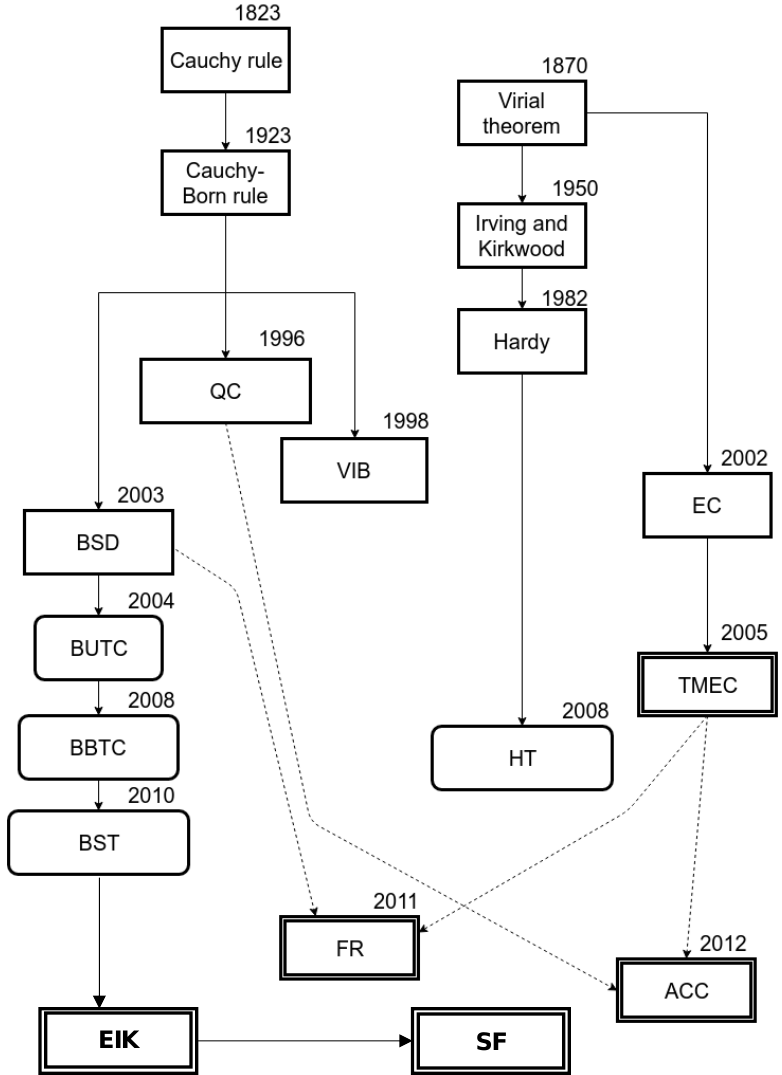
Figure 5. A graphical representation of the evolution of multiscale methods for modelling thermal and mechanical behavior. Rectangles with single border and sharp corners are used for models that only consider mechanical behavior. Rectangles with rounded corners denote models that couple thermal behavior only and double borders are used for models that couple thermal and mechanical behavior. Dotted lines connecting some methods represent the obvious connection between the methodologies even if the relation is not explicitly stated in the derived method.